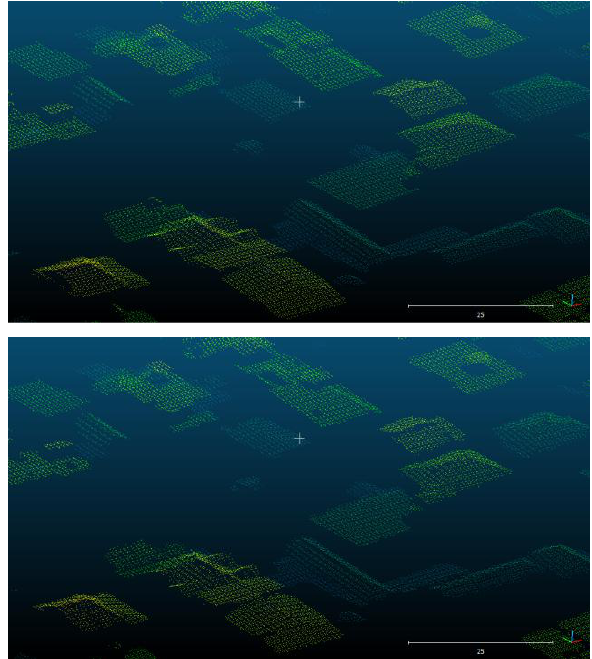
Figure 7. Side view of a part of the final point cloud of buildings coloured by the point height, using the bilateral filtering approach (top) and the scan line smooth filtering approach